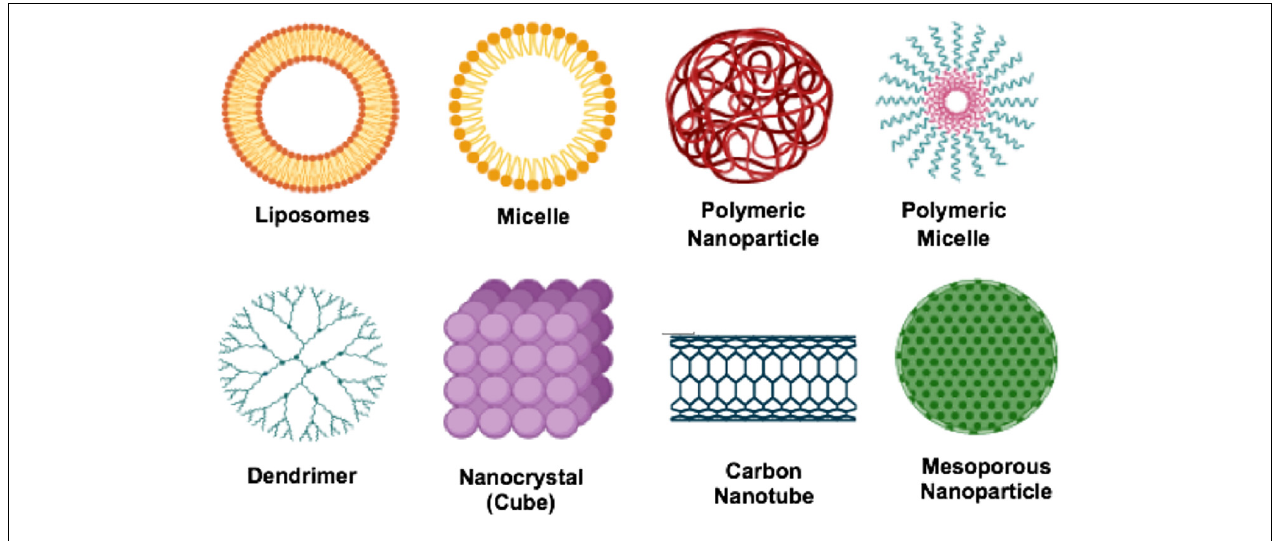
FIGURE 5 | Types of nanocarriers for drug